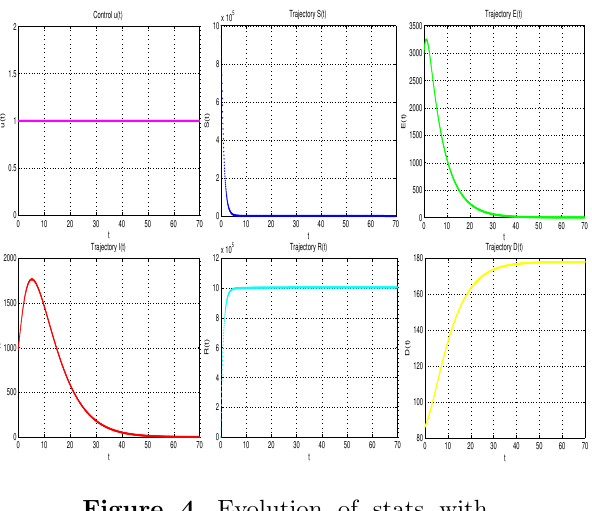
Figure 4. Evolution of stats with vaccine, after 70 days.